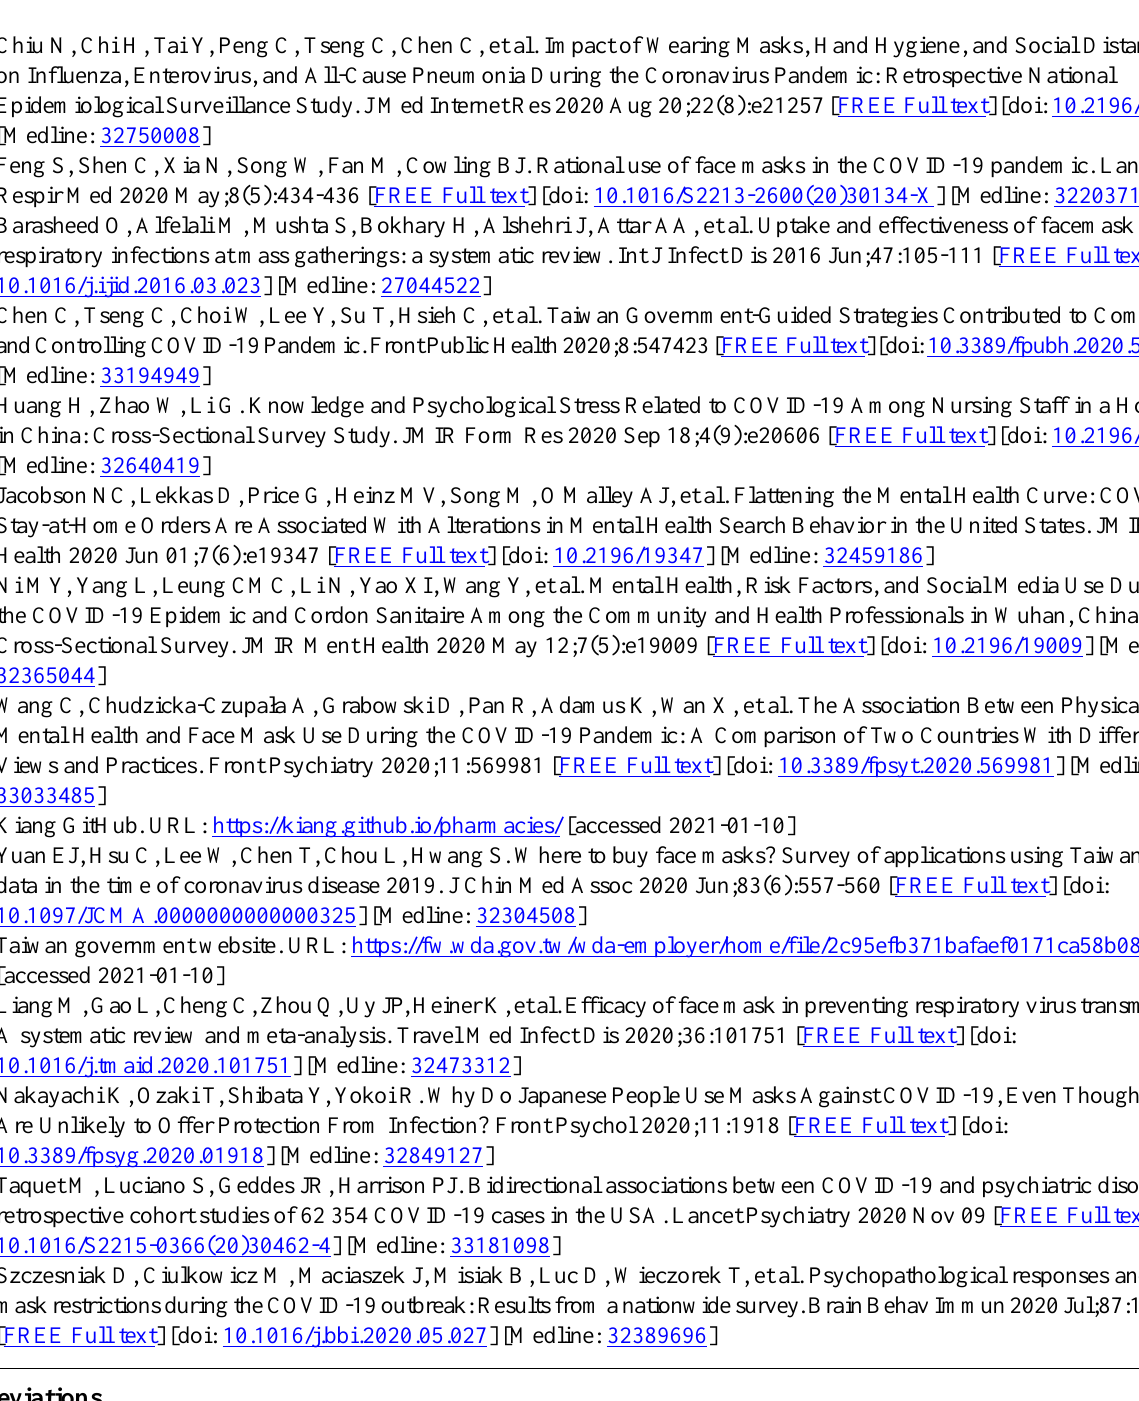
CDC: Centers for Disease Control,